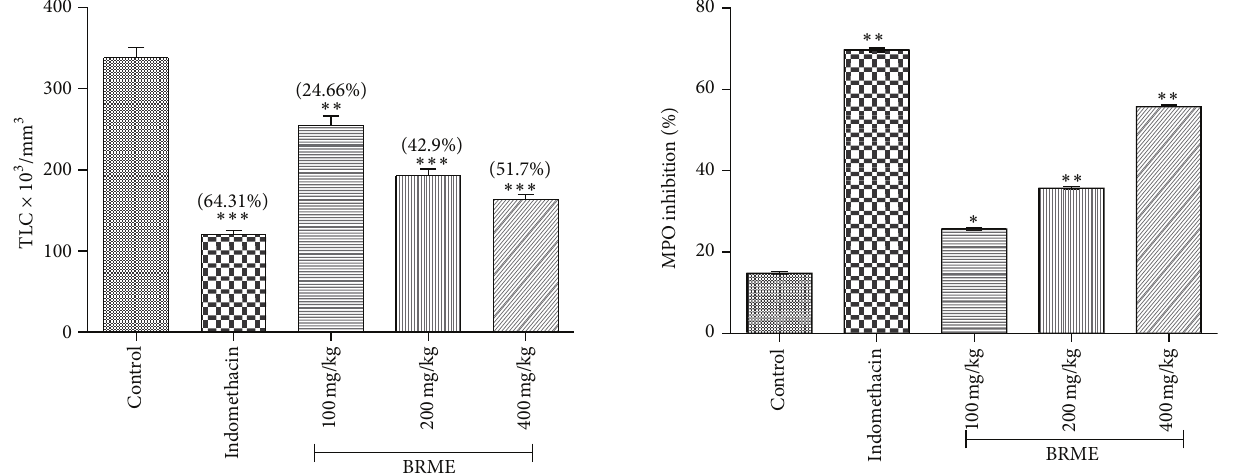
Figure 6: Effect of the BRME and indomethacin on the WBC count ( × 10 3 /mm 3 ) in the paw fluid during acute inflammation induced by carrageenan. Each value represents the mean ± SEM ( 𝑛 = 6 ). Experimental groups were compared to control, ∗∗ 𝑃 < 0.01 , ∗∗∗ 𝑃 < 0.001 (one-way ANOVA followed by Dennett’s test). (%) represents percentage reduction of the total white blood cell count in paw fluid after inflammation.